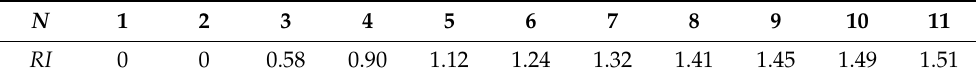
Table 5. Random consistency index ( RI